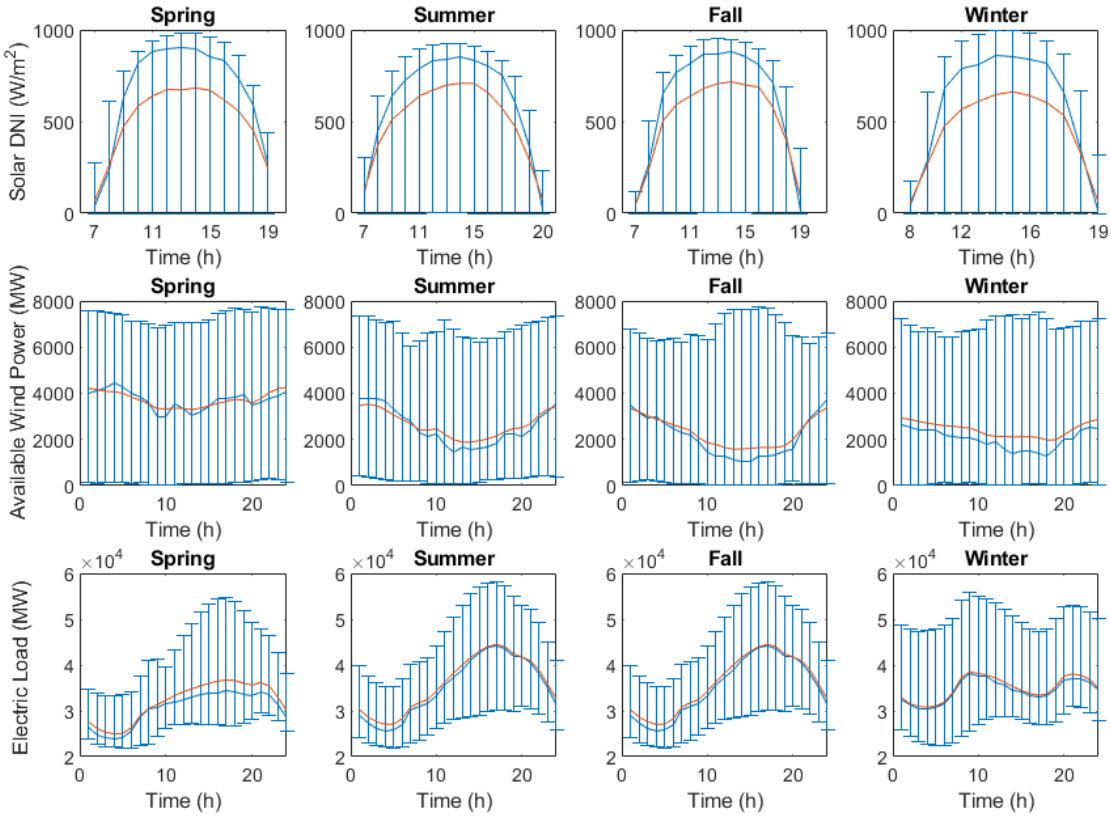
Figure 1. Historical data for solar DNI, wind power availability, and electric load [17,27].